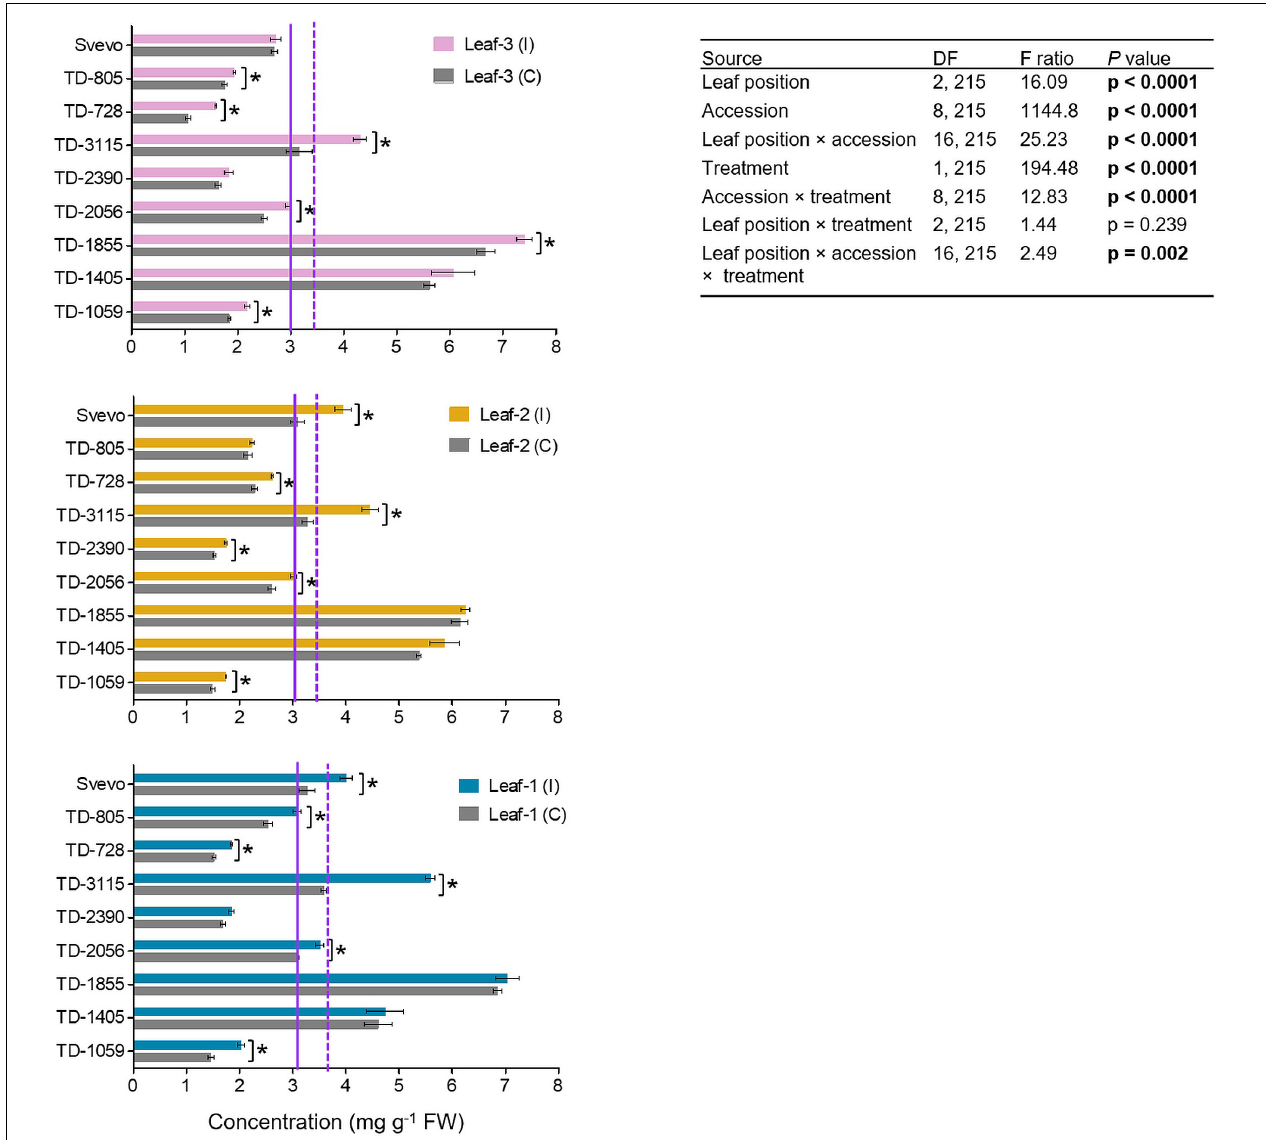
FIGURE 4 | The levels of DIMBOA of nine selected wheat genotypes. The content of the BXD, DIMBOA, (mg per g FW) was evaluated in leaf-1, leaf-2, and leaf-3 in untreated controls (C) and 96 h following infestation (I) with R. padi using the choice whole cage bioassay. Values are expressed as mean ± SE ( n = 4). The solid and dashed purple lines represent the mean value of each leaf type under control and infested conditions among the accessions, respectively. The effects of leaf position, accession, treatment, and their interaction (leaf position × accession × treatment) were tested by two-way ANOVA analyses. The asterisk represents the significant difference between treatments in a particular accession analyzed by Student’s t -tests ( p < 0.05). In bold are the parameters that were significantly affected, p <